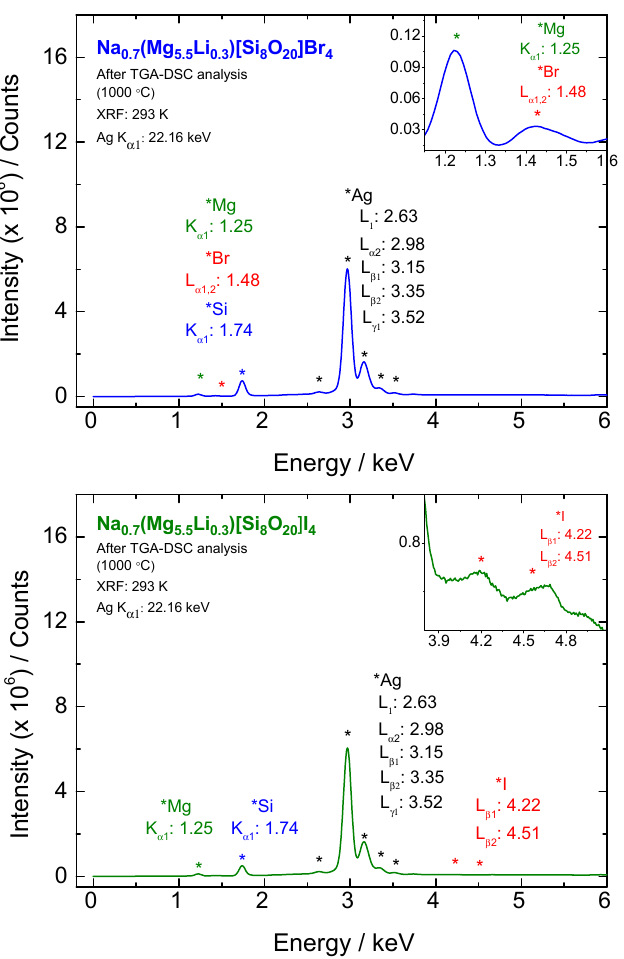
Figure A3. The XRF measurements of bromohectorite ( top ) and iodohectorite ( bottom ) after heating to 1000 °C.